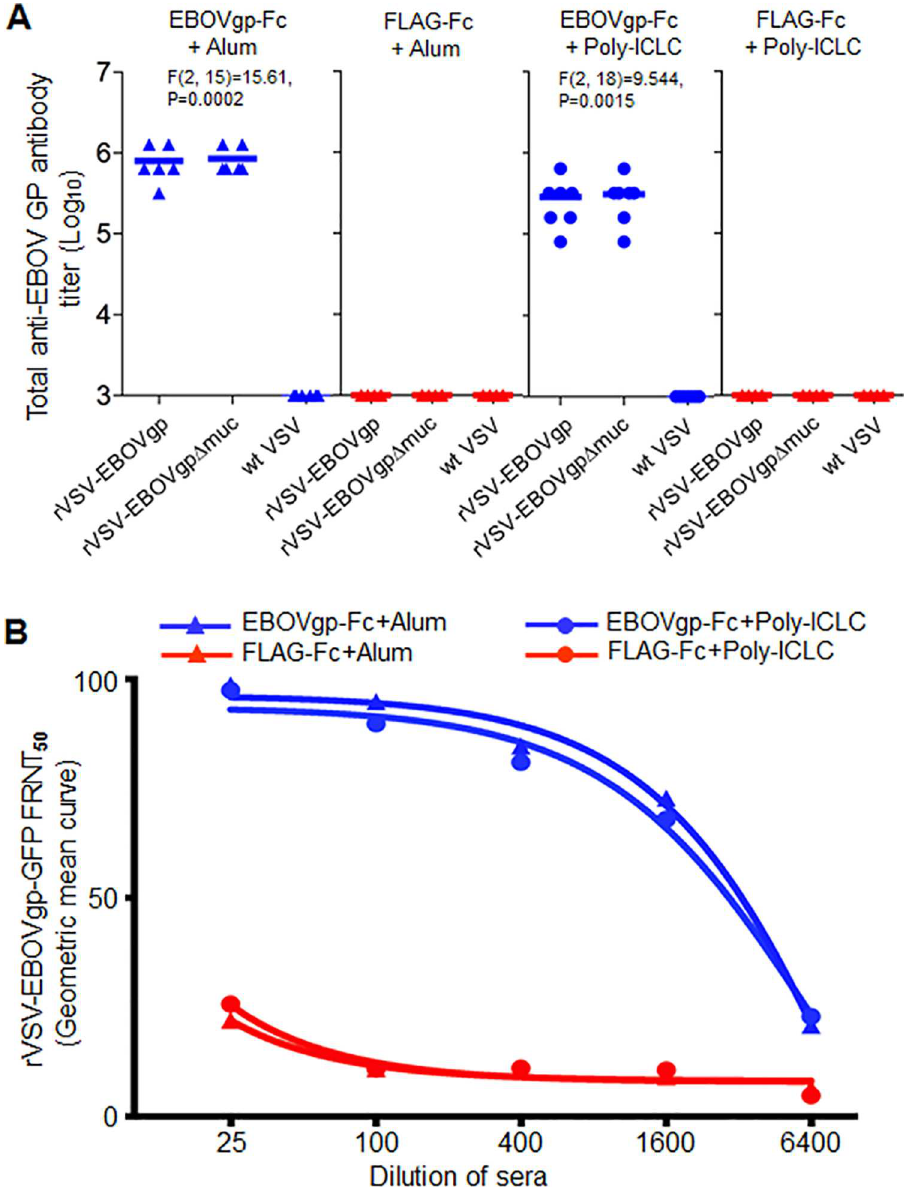
Fig 4. Anti-GPhumoralresponsein Hartleyguineapigsimmunizedwithalum or poly-ICLC adjuvanted EBOVgp-Fc vaccines. Guineapigs were vaccinated with EBOVgp-Fc (n = 6 alum,n = 7 poly- ICLC)or controlFLAG-Fc (n = 6) using alum (triangles) or poly-ICLC(circles)as adjuvants. Sera samples were collectedat day 63 priorto the final (third)boost. (A) Analysis of totalanti-EBOV GP antibodies by an endpointdilutionvirusparticleELISA as in Fig 2C. (B) Analysis of anti-GPneutralizing antibodies by a BSL-2 FRNT. rVSV-EBOVgp-GFPwas incubatedwith four-fold serialdilutionsof sera fromeach guineapig vaccinated with EBOVgp-Fc (blue) or FLAG-Fc (red)adjuvated with alum or poly-ICLC. Vero E6 cell monolayers were infected with the neutralization reactions, and the numberof GFP fluorescent cells was assessed by flow cytometryand the FRNT50was calculatedby Geometricmean curvesas in Fig